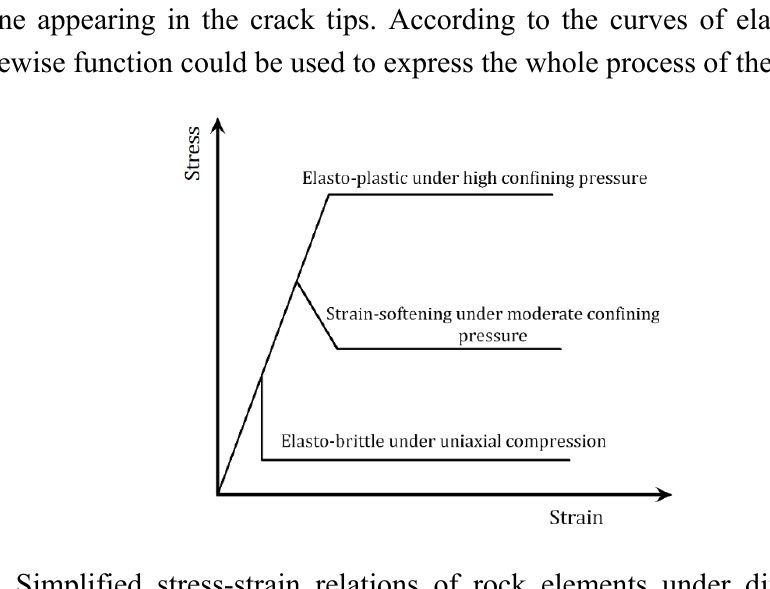
Figure 1. Simplified stress-strain relations of rock elements under different confining pressures within a stressed rock